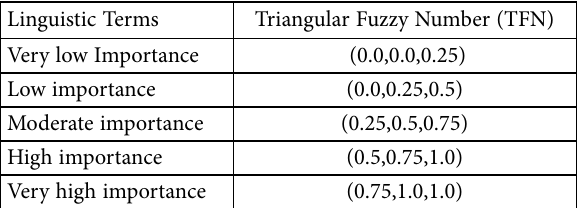
Table 2. Linguistic terms for weighting the criteria Linguistic Terms